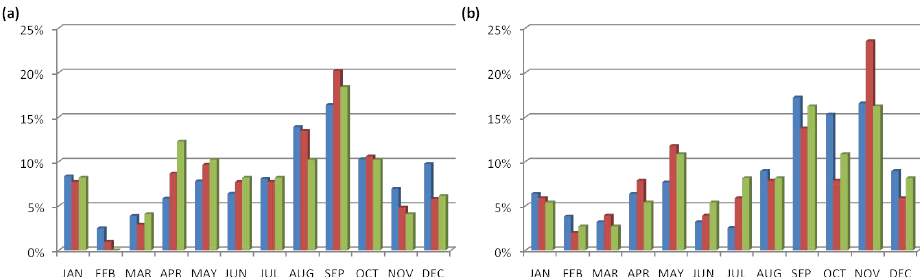
Fig. 2. Monthly distribution (%) of MEDEX events from June 1995 to May 2004 (blue) and from January 2000 to December 2002 (red), and of SIR events from January 2000 to December 2002 (green) for: (a) Catalonia and (b) the Balearic Islands.